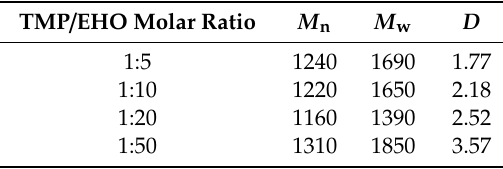
Table 2. Molar mass and dispersity (D) of POXs determined by gel permeation chromatography (GPC).